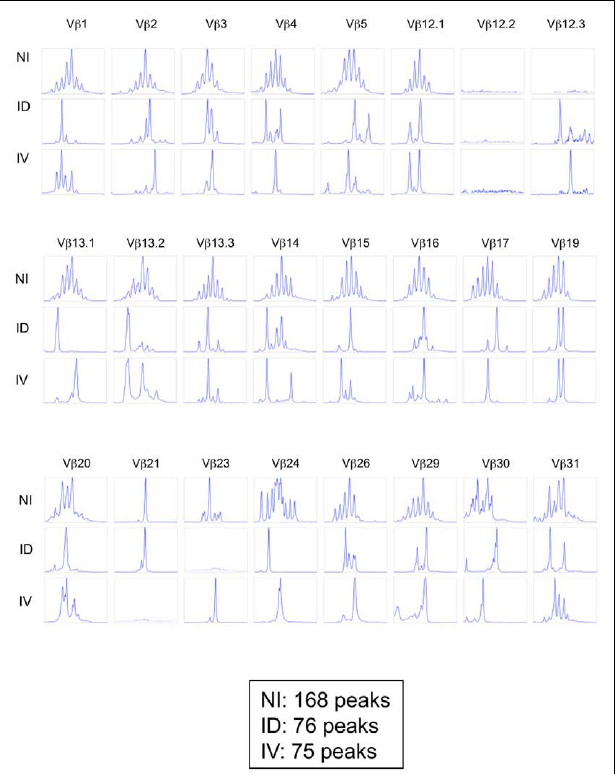
FIGUREA1 | Immunoscope profiles from mice immunized i.d. or i.v. Mice were immunized i.d. or i.v. with 5 × 10 5 K bm1 mOva splenocytes. On day 9, 15 macroscopic lymph nodes and the spleen were harvested and a K b –SIINFEKL tetramer-based enrichment was performed for each mouse. CD8 K b –SIINFEKL tetramer-positive cells were sorted and pooled to obtain 25,000 cells per condition (corresponding to five mice per group). For the non-immunized condition (NI), CD8 + T cells were sorted. An immunoscope was performed to detect the 24V β families (IMGT nomenclature).The immunoscope profile was shown for eachV β family.The total number of peaks is indicated for each condition. Of note the values indicated in this Figure are higher than those reported in Figure 5B as the former represent pooled